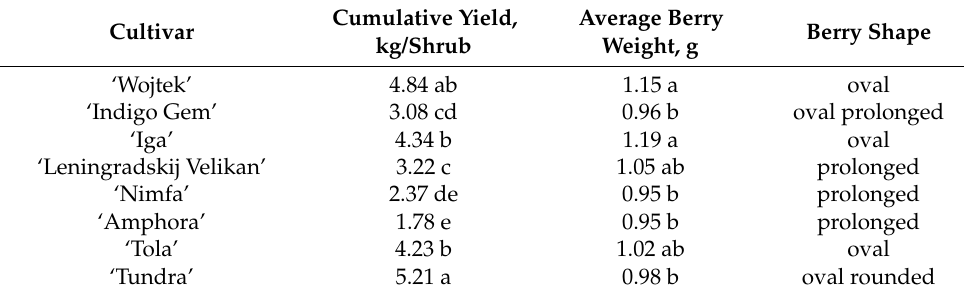
‘Tundra’ oval rounded